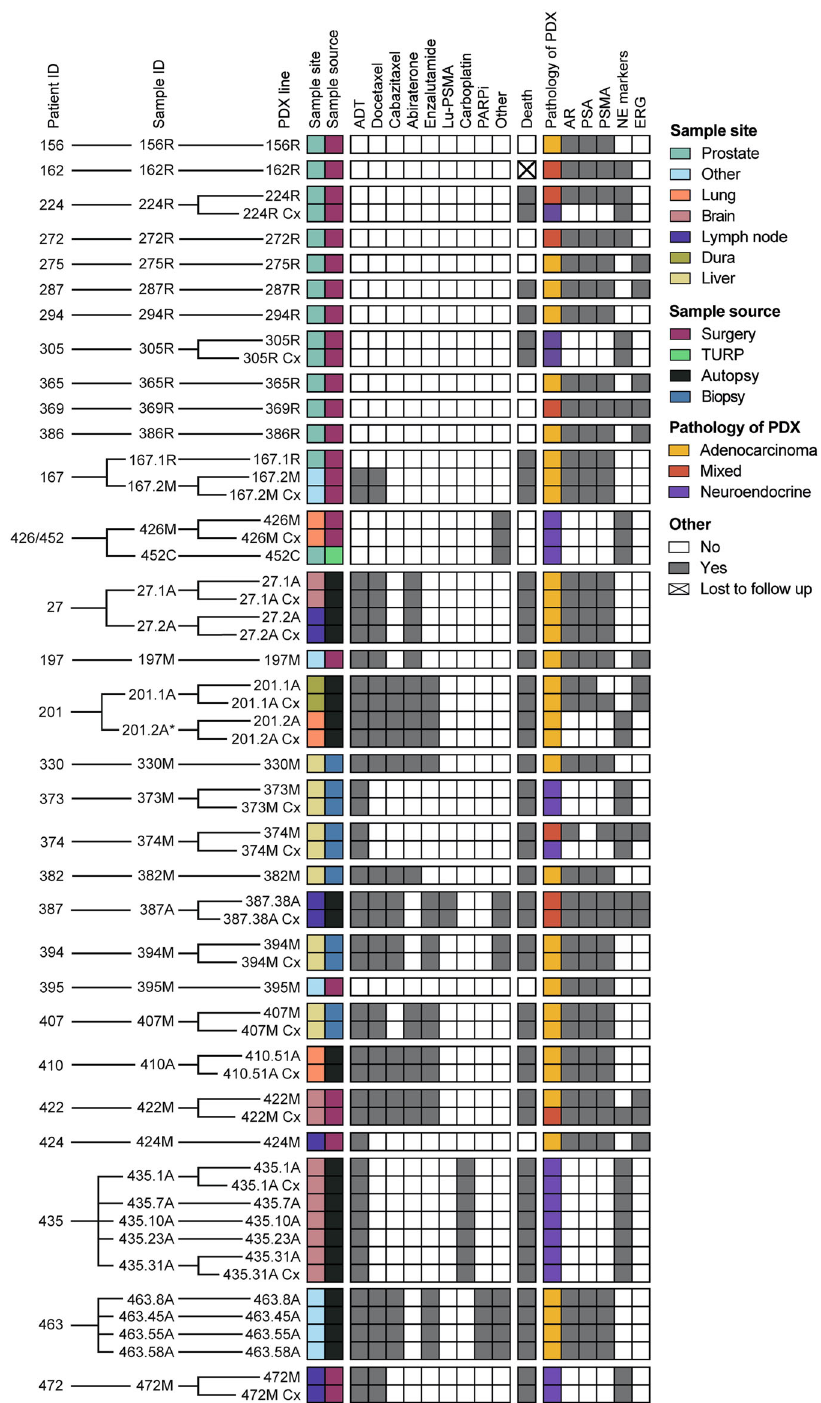
Fig. 1 MURAL Prostate Cancer PDX collection. Heatmap summarising 59 prostate cancer PDXs established from 41 specimens obtained from 30 patients. The sample site, sample source, systemic therapies administered to patients prior to sample collection, clinical outcome at last follow-up, and pathology and biomarker expression of the PDXs are shown. Pathology of the PDXs was determined through histology review by pathologists and expression of phenotypic biomarkers by immunohistochemistry. NE marker staining indicates expression of ≥ 1 of chromogranin A, synaptophysin, and CD56. Immunohistochemistry results are from the latest PDX generation. *PDX 201.2A and PDX 201.2A-Cx are classi fi ed as adenocarcinoma based on pathology review and negative staining for synaptophysin and chromogranin A; however, they have focal staining of CD56. The naming convention for PDXs is a follows: numbers indicate patient ID and tumor site (e.g., 167.1 is patient 167, site 1), letters denote the sample source (R — radical prostatectomy; M — biopsy or surgical sample of metastasis; C — castration-resistant primary tissue; A — autopsy tissue), and Cx denotes subline grown in castrated mice.